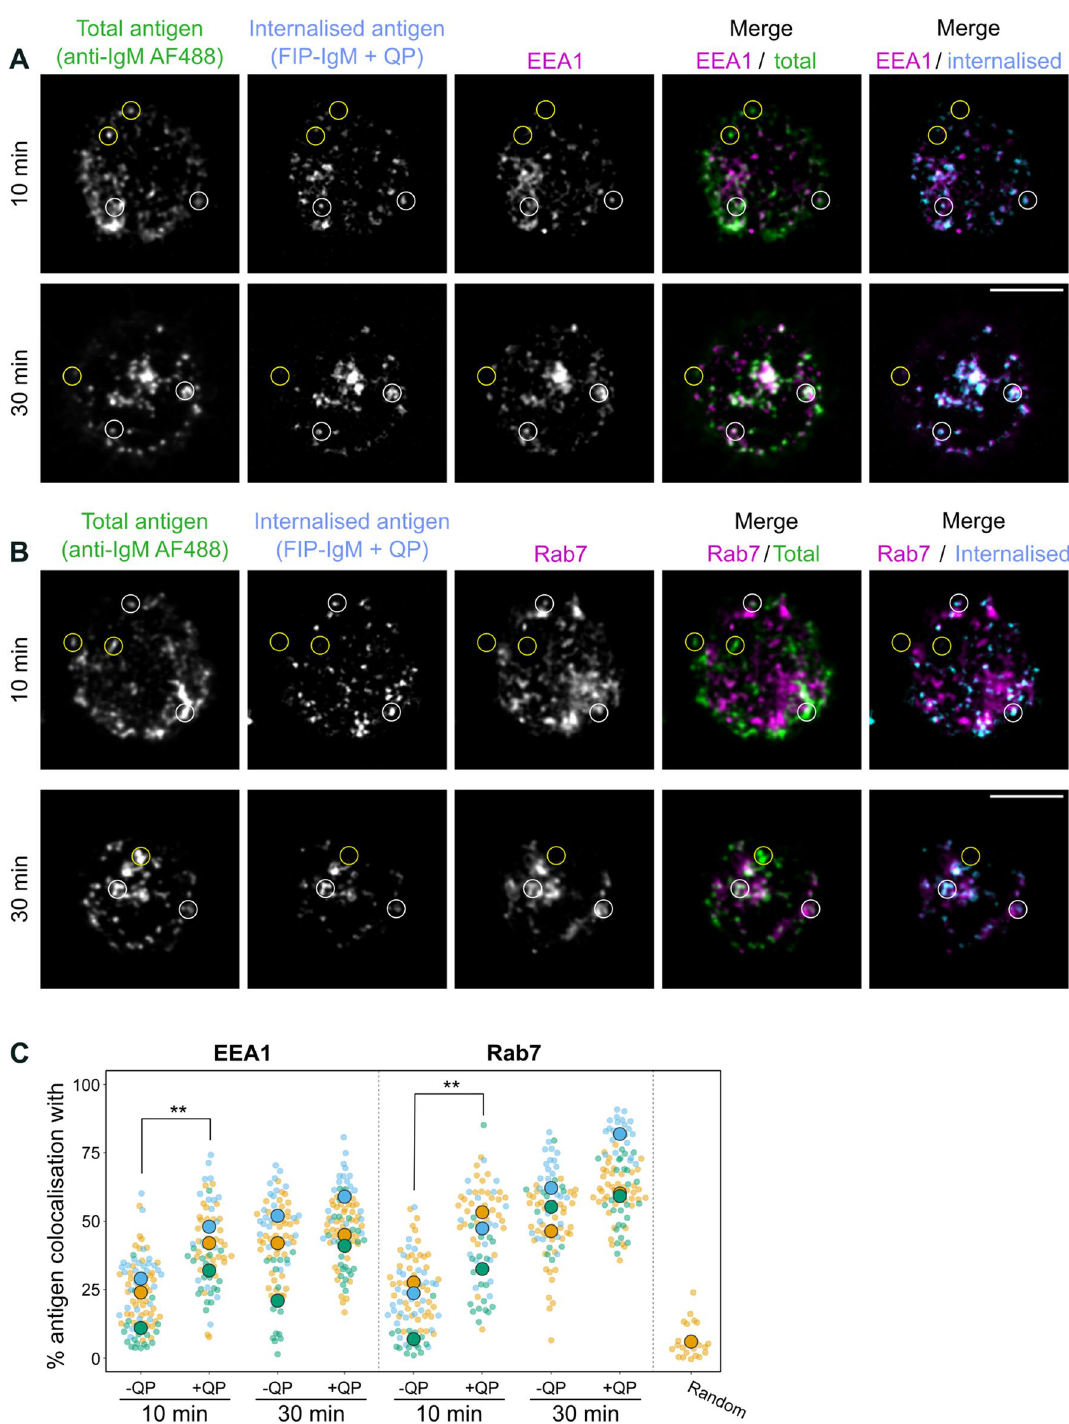
Figure 2. Colocalisation of the antigen with early and late endosomal markers. ( A , B ) B cells were engaged with ATTO-FIP-IgM and anti-IgM AF488, and activated for 10 or 30 min at 37 °C. After activation, cells were incubated with QP for 10 min on ice, fixed and stained for ( A ) Rab7 or ( B ) EEA1. Images were acquired using a SDCM. A representative image of one cell (stack, sum projection) is shown. The white and yellow circles mark an example of internalised or non-internalised antigen, respectively. Scale bar: 5 µm. ( C ) Colocalisation analysis of the internalised antigen with EEA1 and Rab7. B cells were stained with ATTO-FIP-IgM and activated for 10 or 30 min. After activation, cells were incubated with PBS (−QP) or QP (+QP), fixed and stained for EEA1 and Rab7. Images were deconvoluted with Huygens and colocalisation was measured using thresholded Mander’s overlap coefficient (tM1 = % of antigen colocalising with EEA1 or Rab7). Different colours represent independent experiments: the mean of each experiments is shown with large symbols, and small symbols show the measured cells. As a control for random colocalisation, one channel was rotated 90° and colocalisation was measured. ** P < 0.01, paired t-test (n =